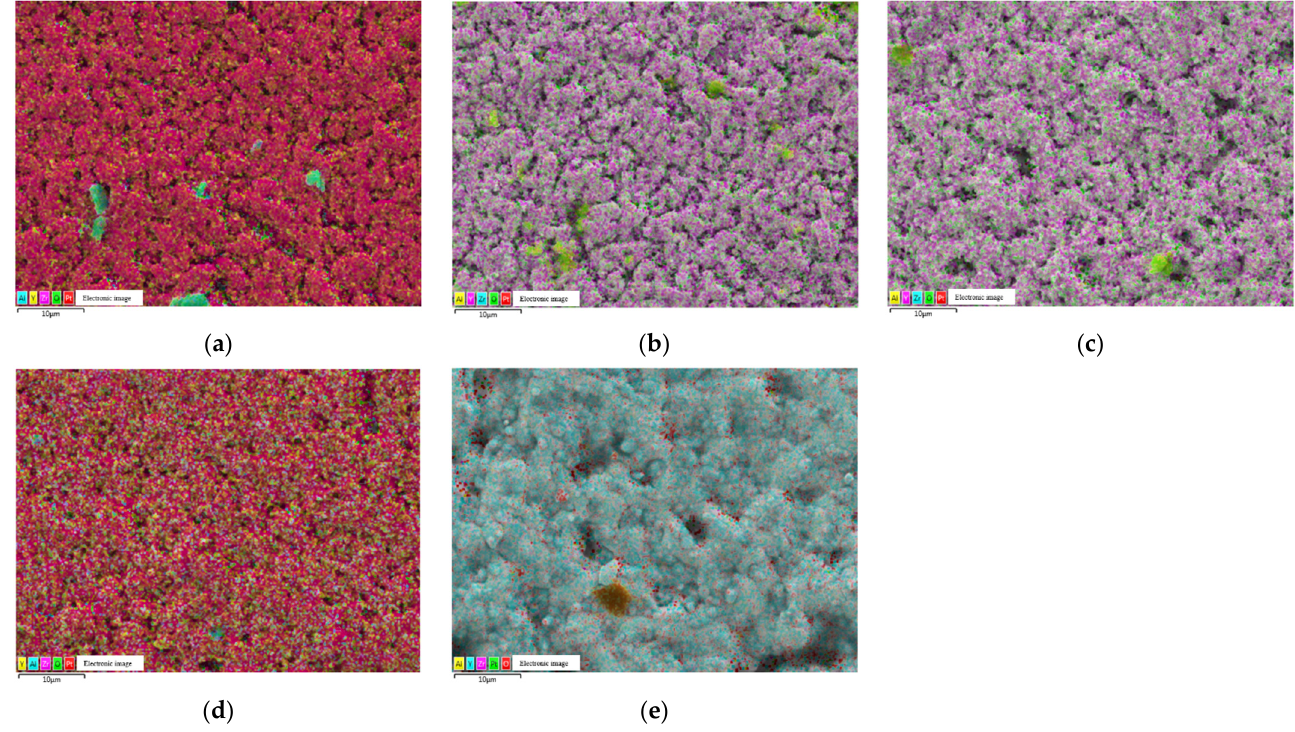
Figure 4. Energy Dispersive X-ray Spectroscopy (EDS) images of Pt/YSZ electrodes fabricated at different sintering temperatures ( a ) 1350 ◦ C, ( b ) 1400 ◦ C, ( c ) 1450 ◦ C, ( d ) 1500 ◦ C and ( e ) 1550 ◦